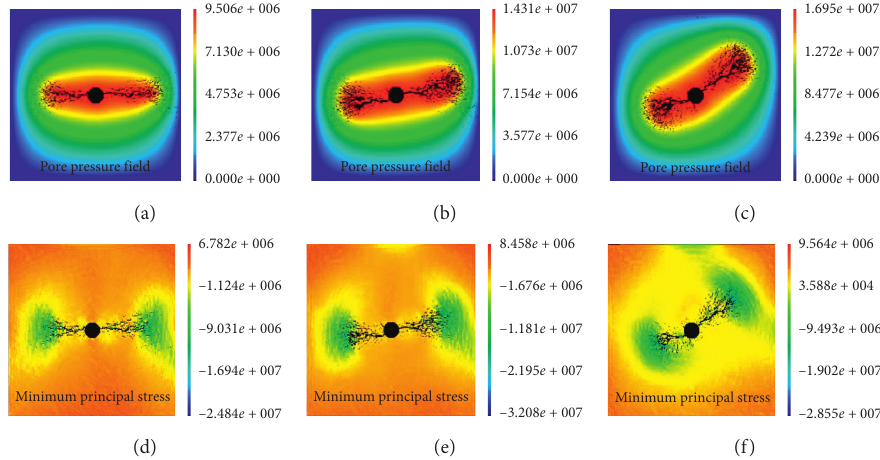
Figure 8: Simulation results of the rock model under varying confining pressure differences. (a) σ σ H � 10MPa and σ V � 8MPa; (c) σ H � 10 MPa and σ V � 10 MPa; (d) σ H � 10MPa and σ V � 5MPa; (e) σ H � 10MPa and σ V � 8MPa; (f) σ H � 10MPa and σ V � 10MPa.